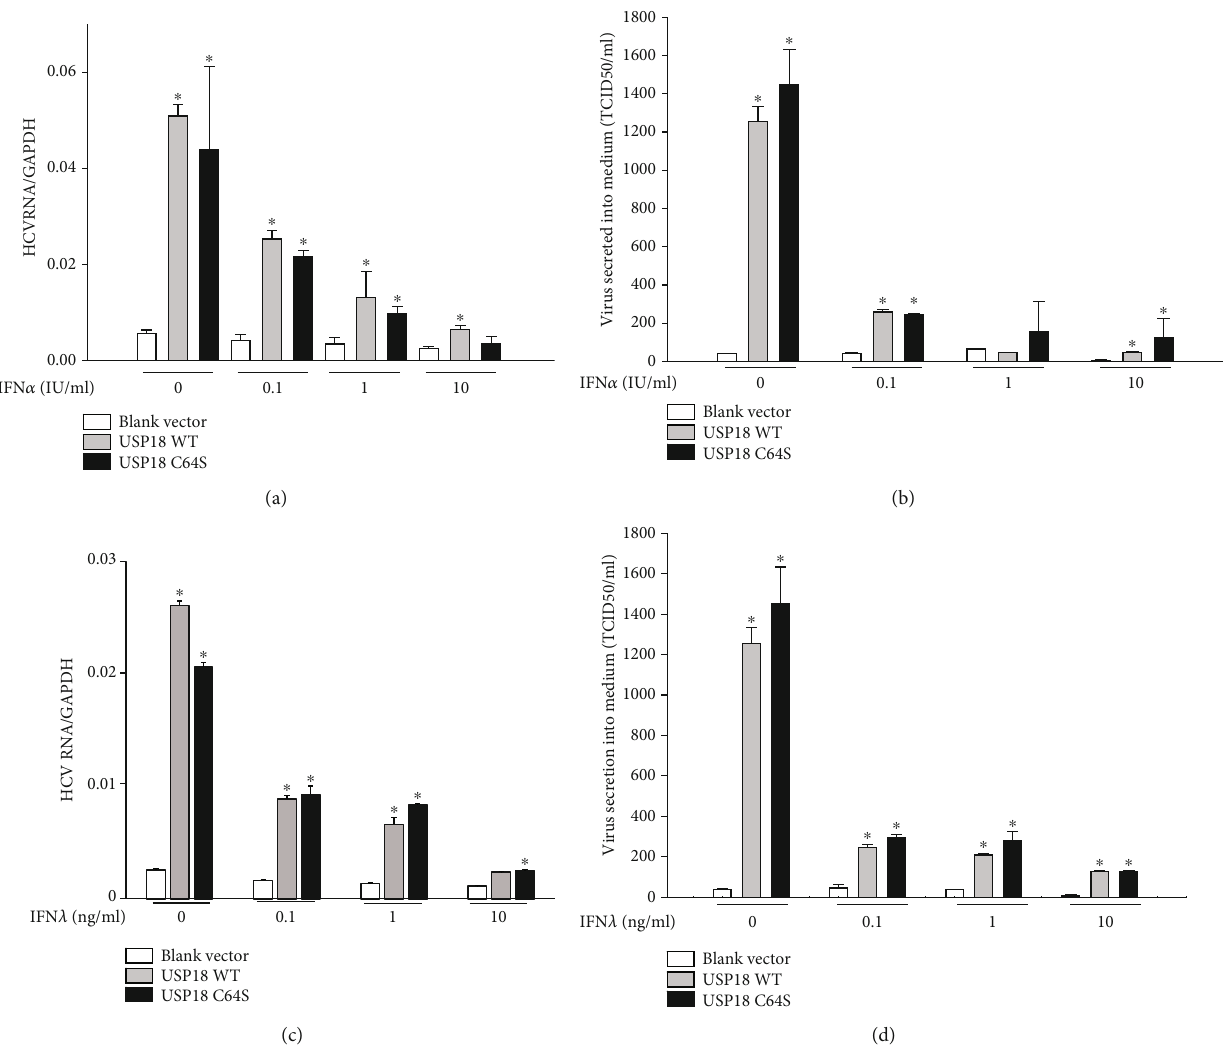
Figure 2: Protease-independent promotion of HCV production and blunting of type I and type III IFN anti-HCV activity by USP18. Huh7.5 cells were seeded at 1 : 5 × 10 5 /well in 12-well plates one day before 2 μ g blank vector pcDNA-DEST53, 2 μ g USP18 WT, or 2 μ g USP18 C64S was transfected. 48 hours posttransfection, J6/JFH1 virus was added ( MOI = 4 ) and incubated for 4 hours before the culture medium was removed. And then, the cells were washed and supplied with fresh medium and cultured for another 48 hours. The intracellular total RNA and the culture medium were collected. J6/JFH1 RNA (a) and J6/JFH1 virion production (b, c) in the presence and absence of IFN α or IFN λ were detected by real-time PCR or limiting dilution analysis, respectively. Results are presented as means ± SD ( n ≥ 3 ). ∗ p < 0 : 05